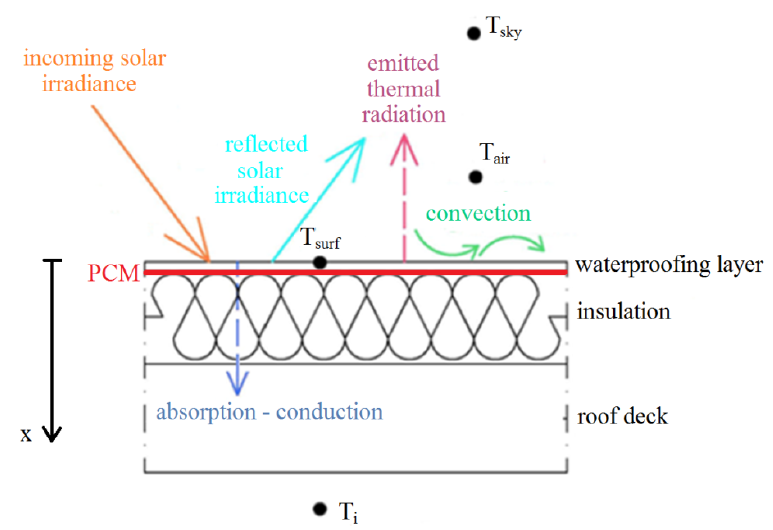
Figure 3. Roof structure and surface heat transfer